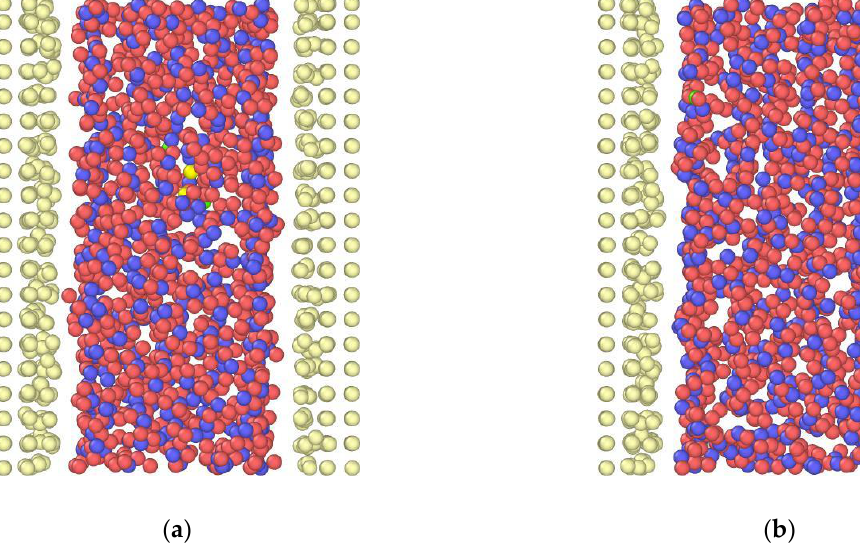
Figure 4. Simulation snapshots for the h = 1.5 nm channel, ( a ) at t = 5 ns, E = 0.0 V/Å and ( b ) t = 20 ns, E = 2.0 V/Å . Particles are: H—pink, O—blue, C—white, Na + —yellow, Cl − —green. z = 0—left side, z = 25—right side, as in Figure 3.